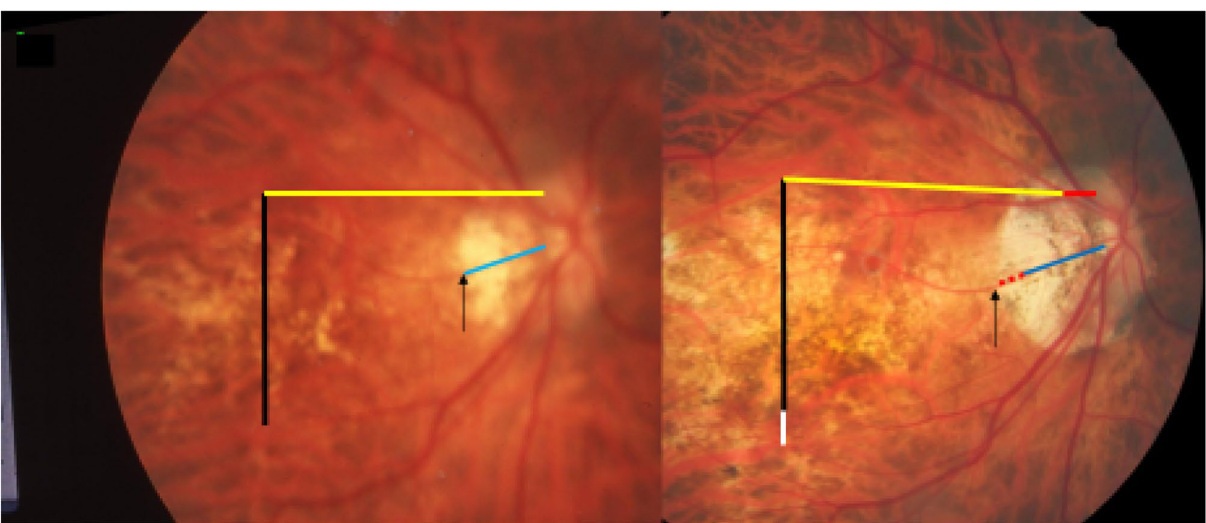
Figure 1. Fundus photographs of a highly myopic eye taken with an interval of 10 years (left image taken in 2001; right image taken in 2011). Note : Development and enlargement of a diffuse chorioretinal atrophy as category 2 of myopic macular degeneration. Elongation of the distance from a choroidal vessel marking to the optic disc border, compared between baseline (yellow bar) and follow-up (equally long yellow bar plus red bar); the elongation of the distance between the disc border and the choroidal marker is similar to the enlargement of parapapillary gamma zone without large choroidal vessels (black arrow) (2001: deep blue line; elongation in 2011: dotted red line); elongation of the distance between two choroidal vascular markings, compared between baseline (vertical black bar) and follow-up (equally long vertical black bar plus white